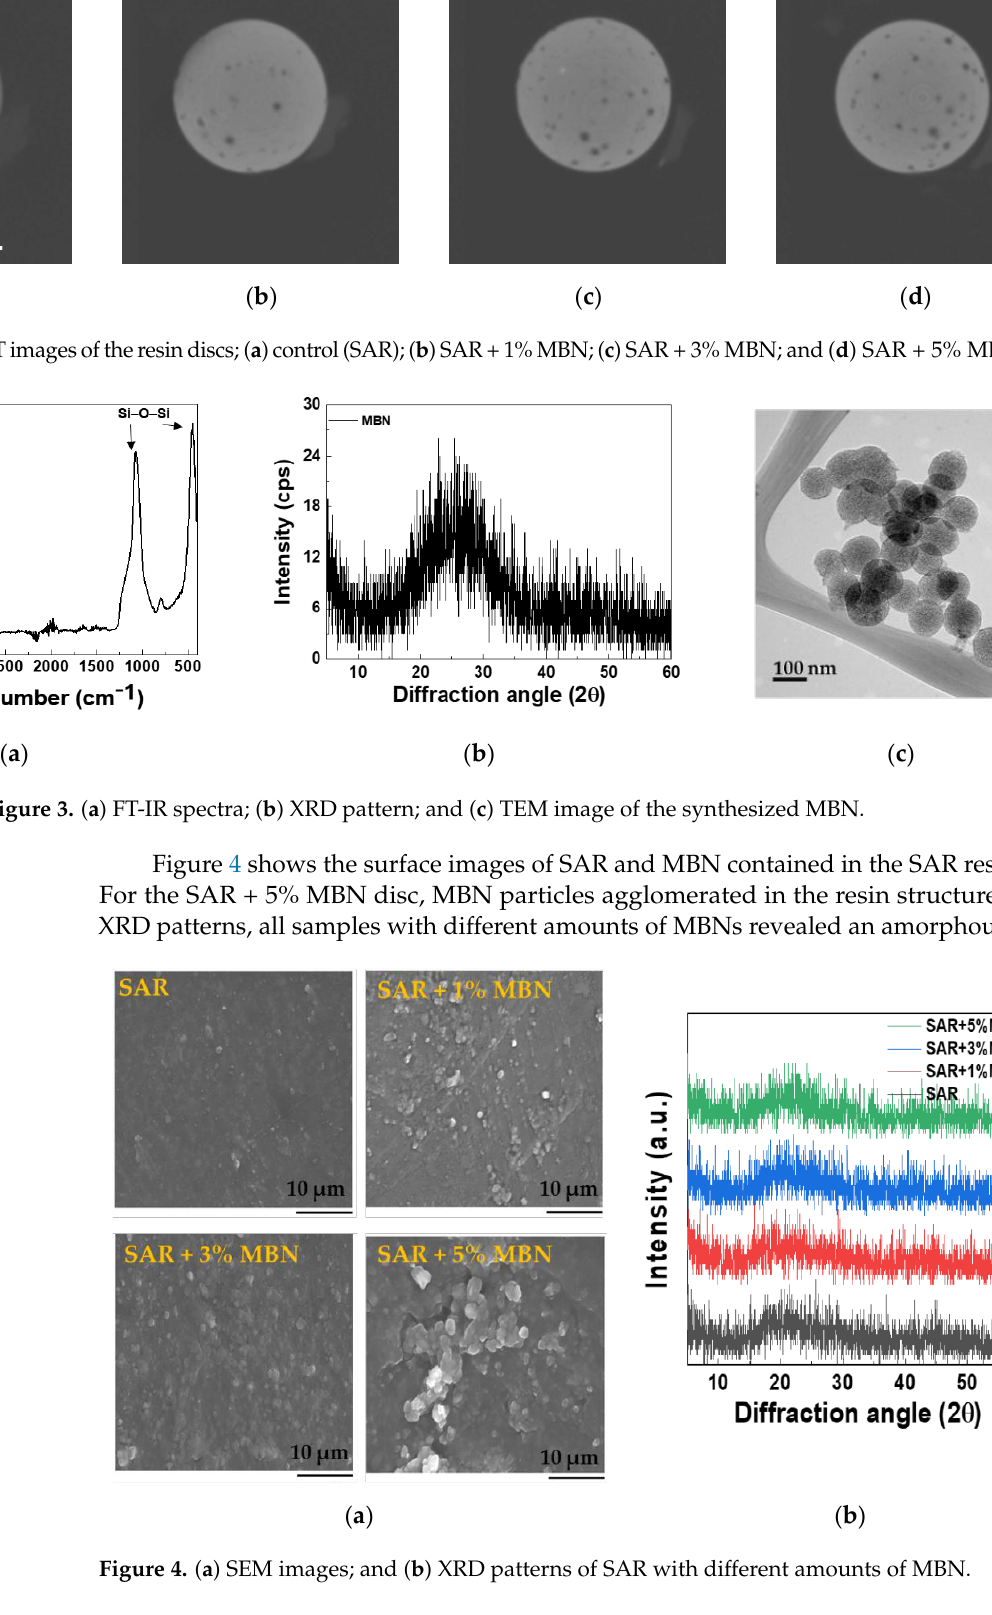
Figure 4. ( a ) SEM images; and ( b ) XRD patterns of SAR with different amounts of MBN.